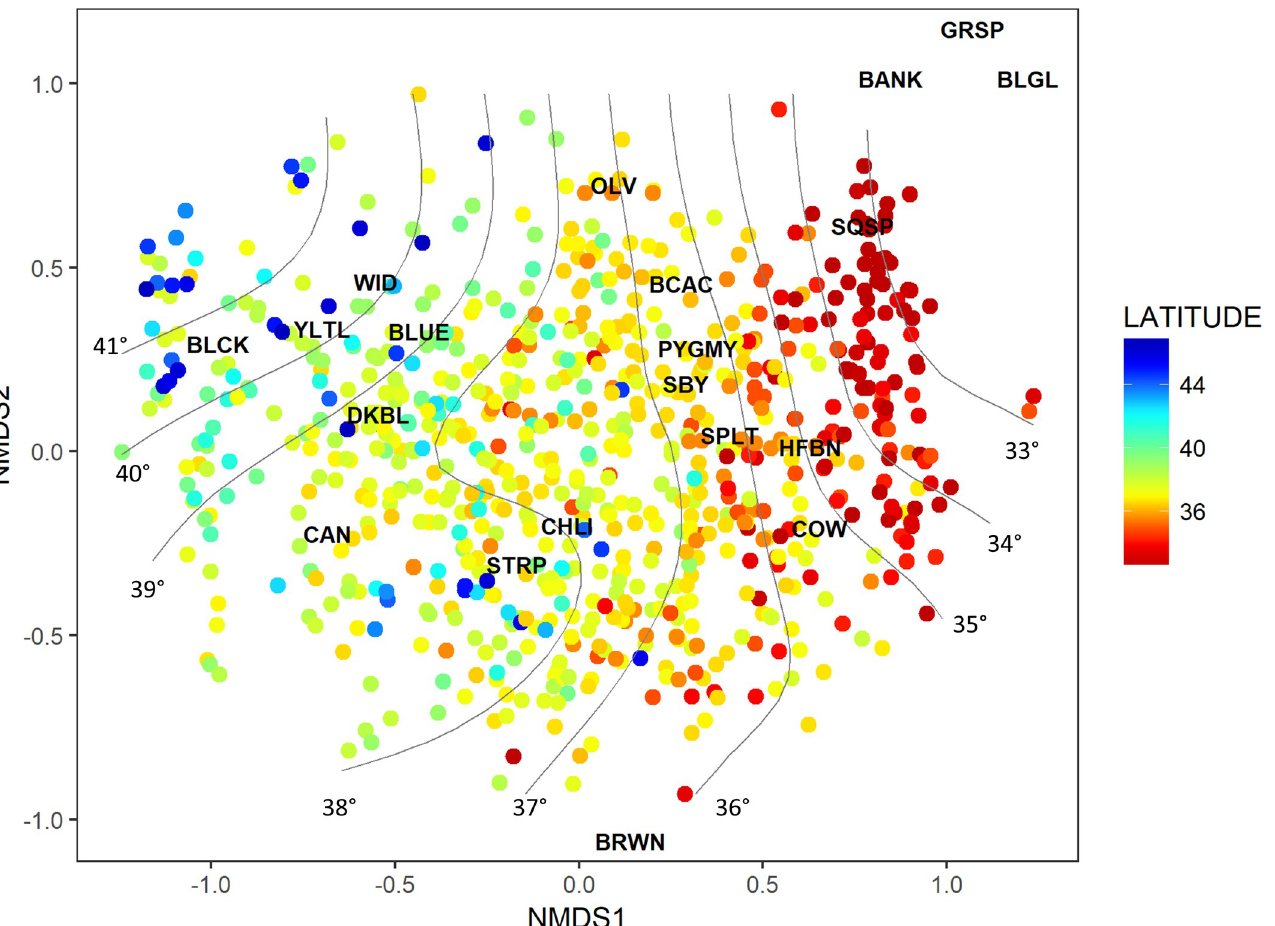
Fig 9. Spatial organization of rockfish taxa based on Non-metric Multi-Dimensional Scaling (NMDS) results. Latitude contours were predicted using a generalized additive model. Common names as follows, BLCK = Black, YLTL = Yellowtail, WID = Widow, BLUE = Blue/Deacon, DKBL = Darkblotched, CAN = Canary, STRP = Stripetail, CHIL = Chilipepper, BRWN = Brown, OLV = Olive, BCAC = Bocaccio, PYGMY = Pygmy, SBY = Shortbelly, SPLT = Splitnose, HFBN = Halfbanded, COW = Cowcod, SQSP = Squarespot, BANK = Bank, BLGL = Blackgill.